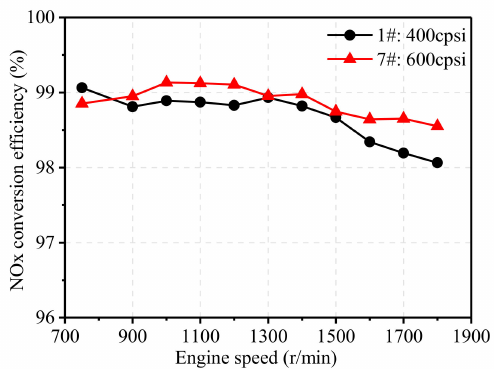
Figure 17. E ff ect of pore density on NOx conversion e ffi ciency.